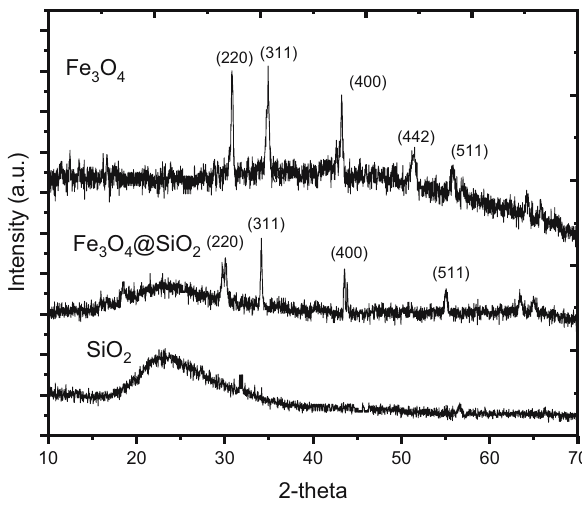
Figure 1: XRD patterns of Fe 3 O 4 @SiO 2 in comparison with Fe 3 O 4 and SiO 2 .